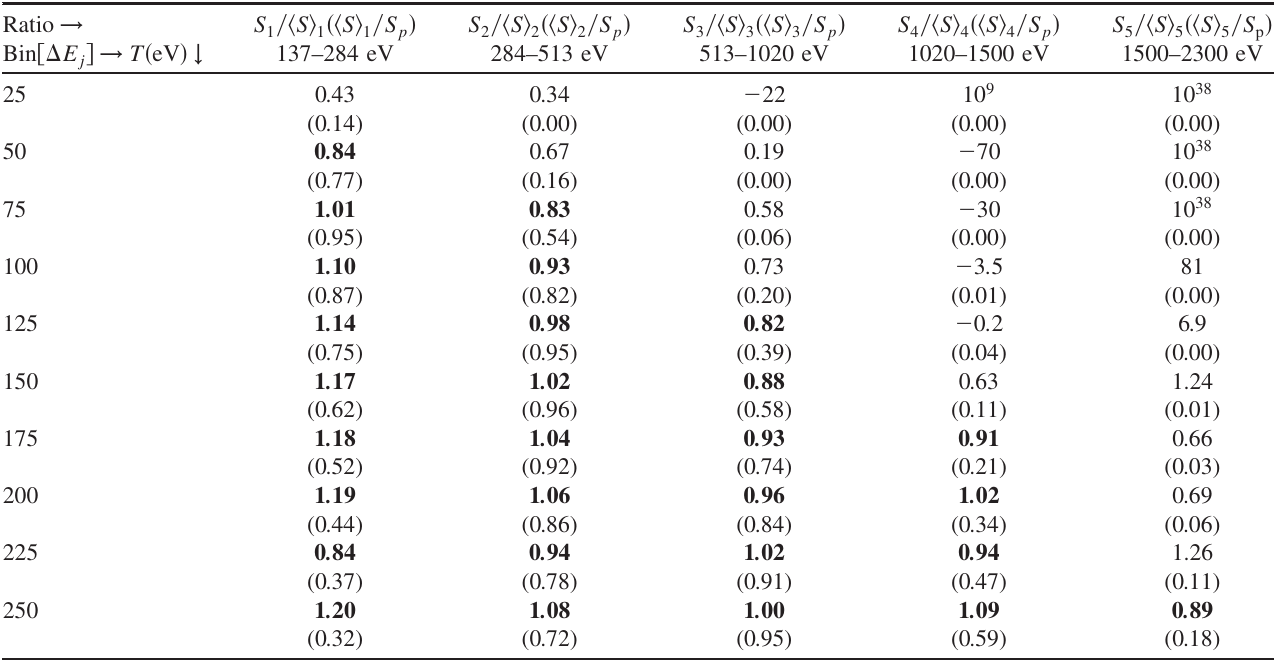
= h S i in each unfold bin j for various j j (cid:5) 1 .) Also shown are the bin intervals = h S i j j in ½ (cid:1) E (cid:7) bb